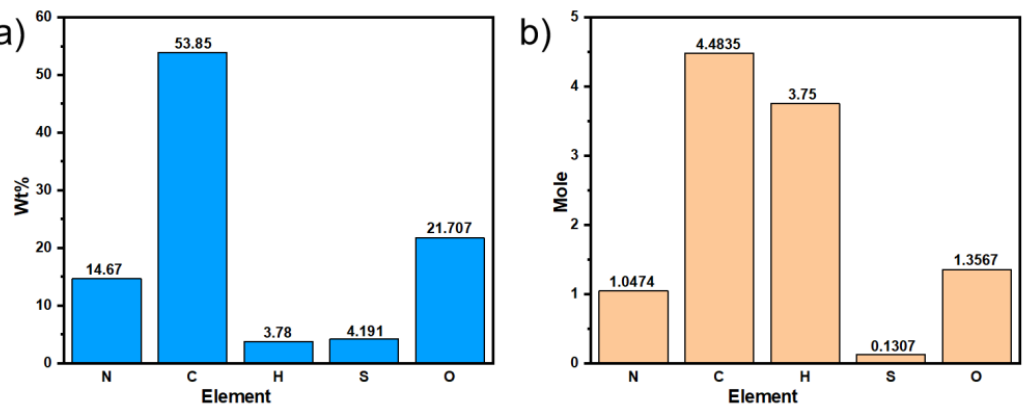
Figure 7. Each element of PPy/CNCs ( a ) wt% (The content of each element is less than 1% error); ( b ) mole. Table 1. Elemental analysis (wt%, molar ratio) of PPy and PPy/CNCs. Sample